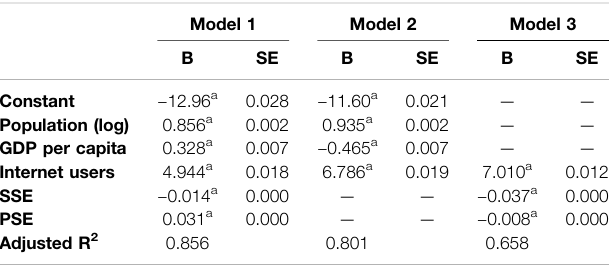
TABLE 4 | Models of socioeconomic factors for the geographies of citizen science. The dependent variable is the logarithm of the number of contributions from each country. Different models consider different sets of independent